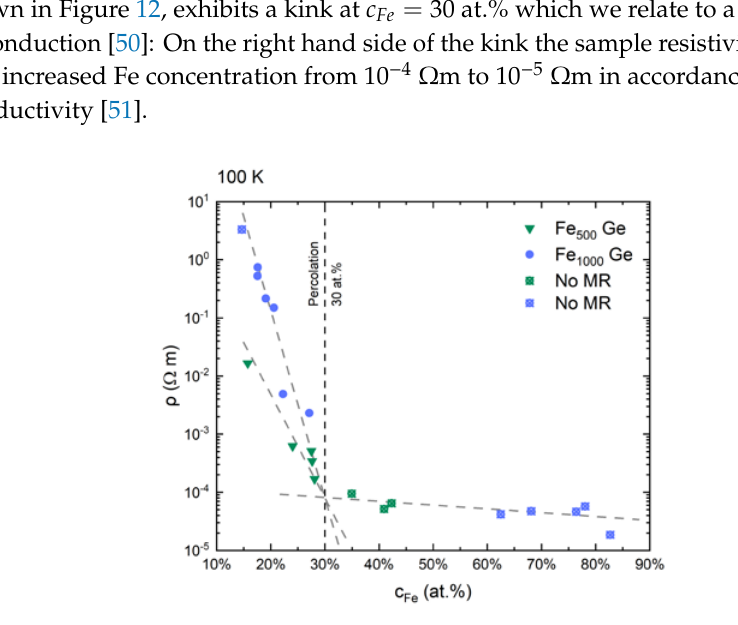
( b ) Figure 11. ( a ) Absolute resistance vs. magnetic field of sample G14 recorded at 7 K . The arrows and the color coding indicate the sweeping direction of the field. The points of maximum resistance at